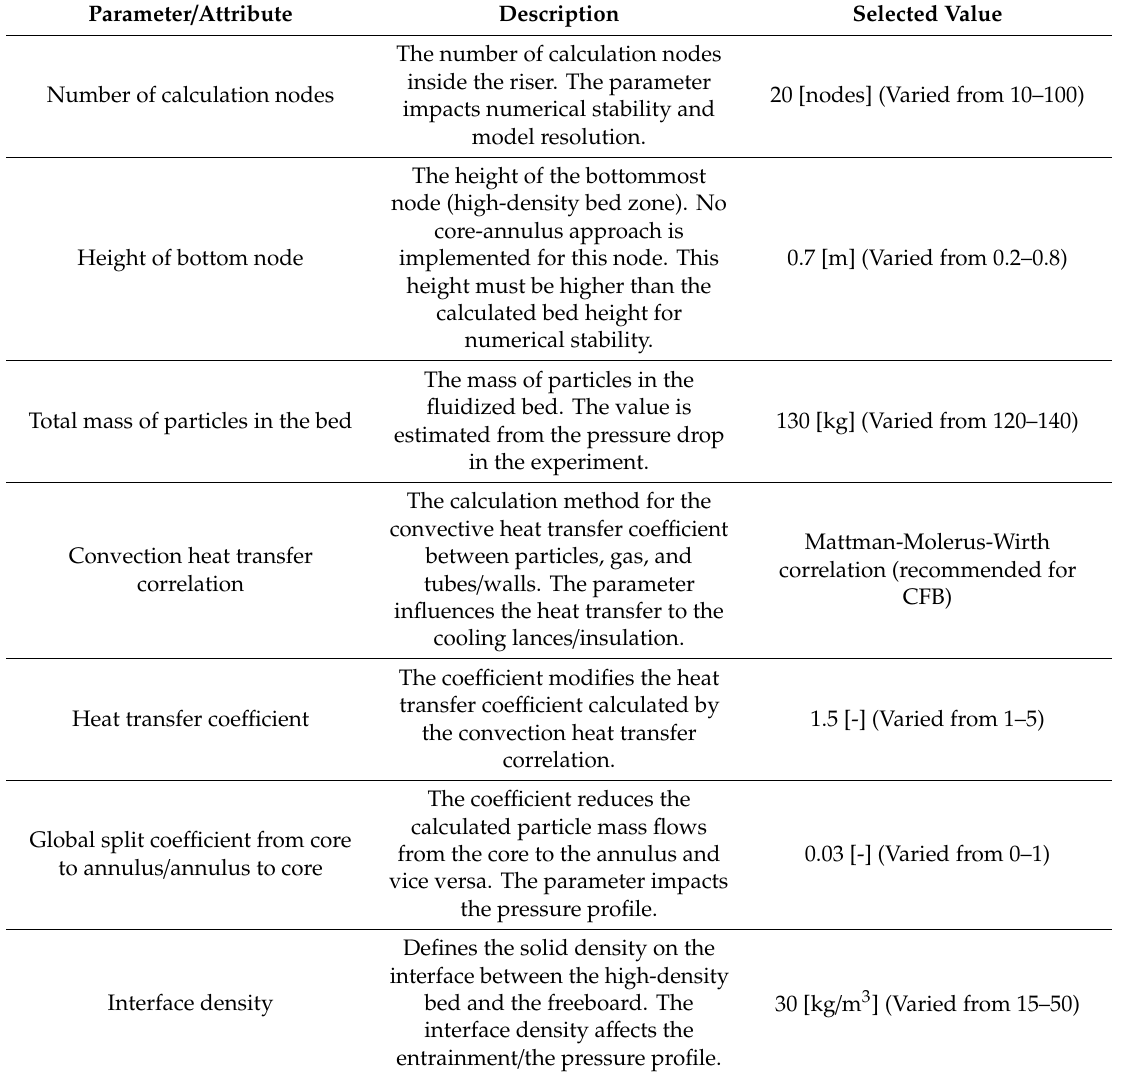
Table 10. Attributes / parameters of the CFB combustor